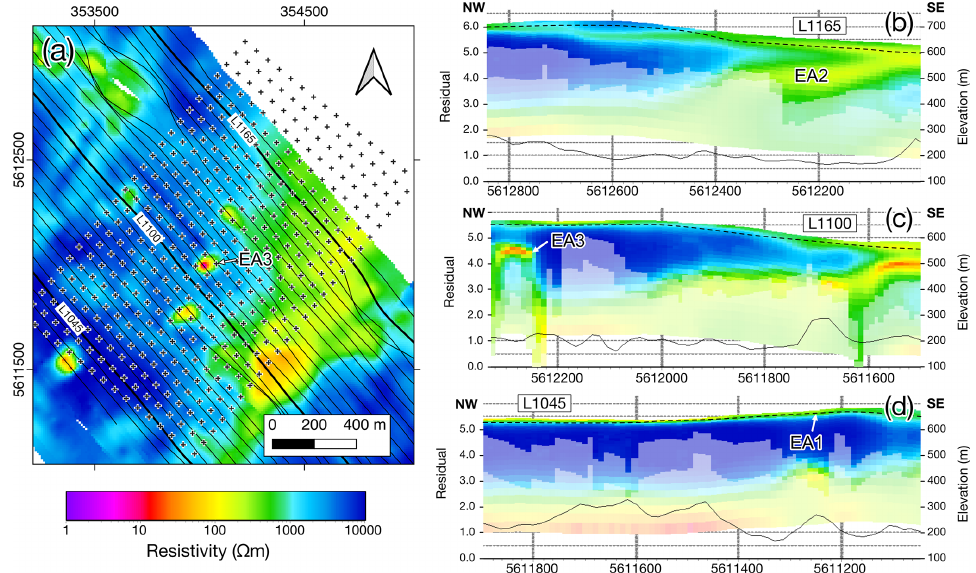
Figure 10. VTEM™ ET resistivity data. (a) Map of the study area including seismic station array (crosses) and VTEM flight lines (black lines). Also shown is the resistivity distribution at a depth of 70–80m (obtained with Kriging using an exponential variogram). (b–d) Resis- tivity sections along selected flight lines (highlighted in a ). Sections have been clipped to the extent of the seismic array. Black line represents data misfit (read against the left axis). The white shading in the section indicates the estimated depth of investigation (DOI). The stippled line indicates the bottom of the Quaternary cover as interpolated from drilling (source: Sächsisches Landesamt für Umwelt, Landwirtschaft und